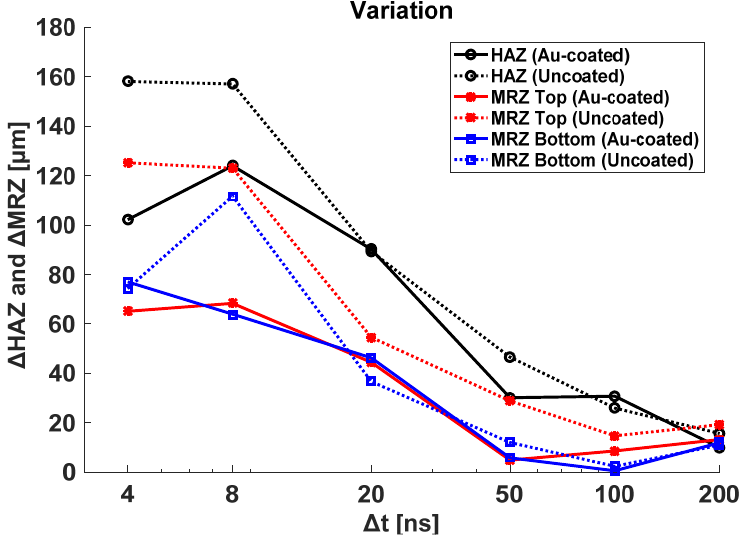
Figure 7. Variation of HAZ, MRZ top, and MRZ bottom with different pulse durations.